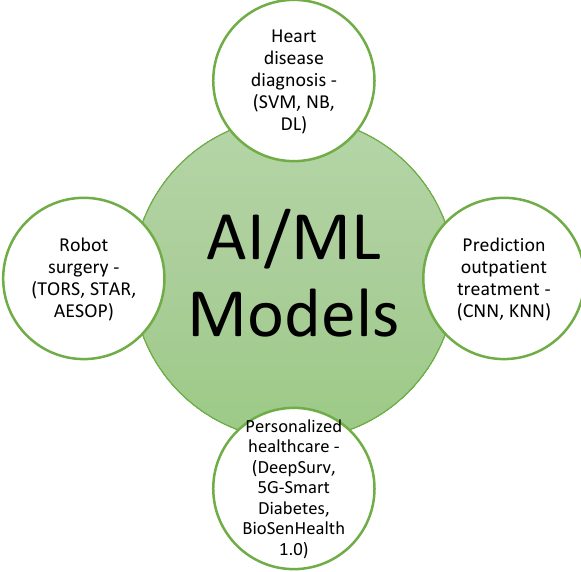
Figure 4. AI/ML algorithms and their application areas in healthcare.